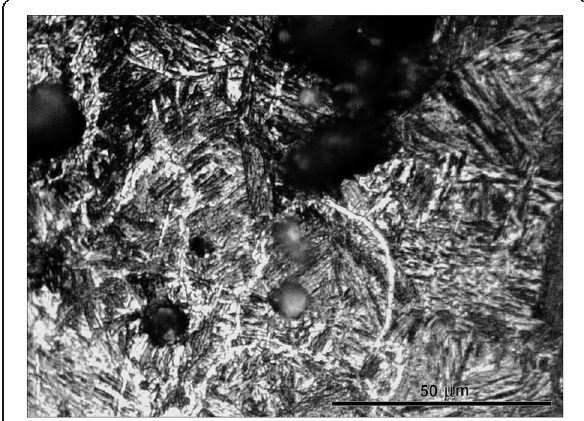
Fig. 3 Optical micrograph of SAE 5130 post-torching. Widmanstatten ferrite and martensite and some porosities could be observed